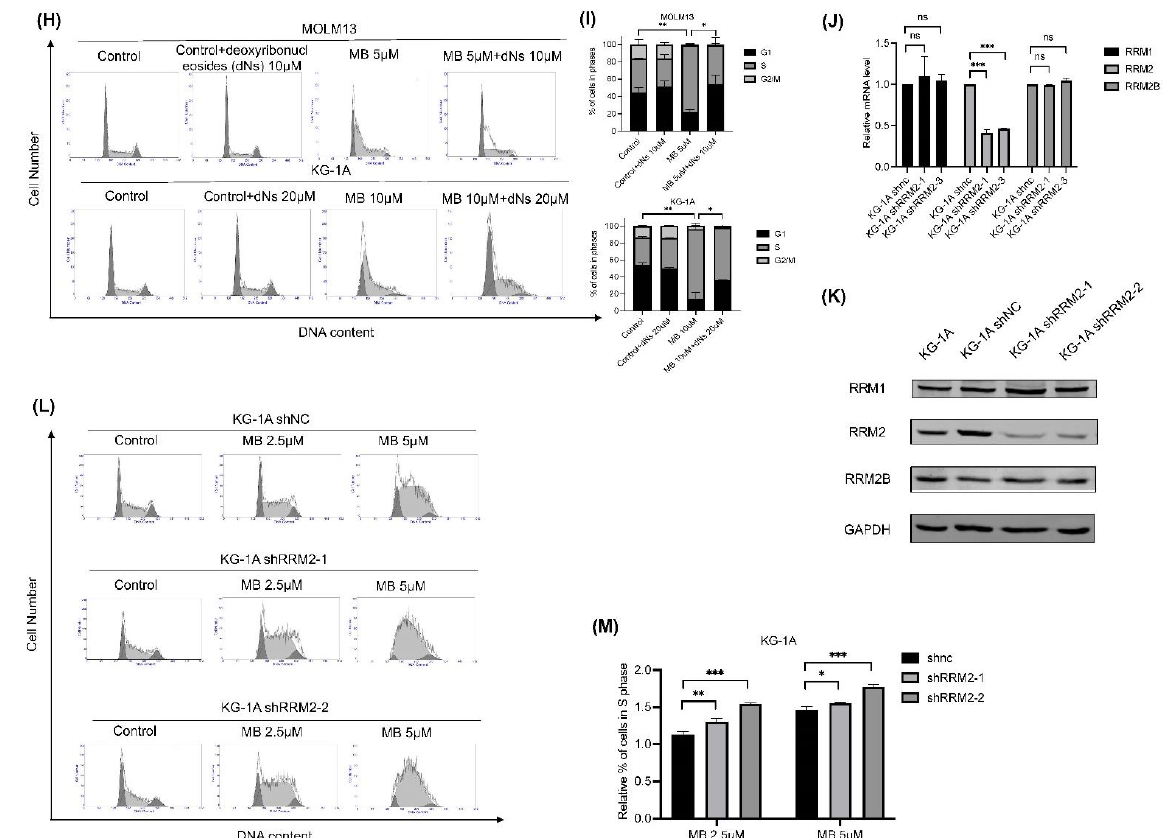
Figure 3. MB inhibited cell growth and DNA synthesis by inhibiting RNR enzymatic activity in AML cells. ( A ) MTT assays were performed on tumour cells treated with different doses of MB or HU for 72 h, and the solvent was used as negative control. ( B ) AML cells were treated with different doses of MB for 24 h or 48 h, and the EdU incorporation was examined with flow cytometry (FCM). ( C , D ) AML cells were treated with the indicated concentrations of MB for 24 h and then fixed with 70% ethanol, stained with PI, and subjected to an FCM analysis of the cell cycle distribution. The quantitative results of the number of cells in S phase are shown in a bar plot. ( E , F ) AML cells were treated with different doses of MB for 48 h and then analysed using FCM (PI & Annexin V method). Quantitative results of apoptotic cells are shown in bar plots. ( G ) AML cells were treated with MB for 24 h or 48 h. Whole-cell lysates were subjected to Western blotting with anti- γH2AX and anti - H3 antibodies. ( H , I ) AML cells were treated with MB alone or in combination with dNs for 24 h and then subjected to FCM analyses. The quantitative results of the numbers of cells in different phases of the cell cycle are shown in bar plots. ( J ) KG-1A cells were stably transfected with shRNAs targeting RRM2 (shRRM2-1 and shRRM2-2) or a negative control (shNC). The knockdown effects were measured with qRT-PCR. ( K ) The knockdown effects were measured with Western blotting. ( L , M ) Cells were treated with different doses of MB for 24 h and then subjected to FCM assays. The relative number of cells in the S phase is shown in a bar plot. All experiments described above were performed at least three independent times. Error bars represent the SD. * p < 0.05, ** p < 0.005, *** p < 0.0005 compared to the control group. Full Western blot images and western blotting gray value analysis can be found at Supplementary Figures S5 and S6, Tables S1 and S2.